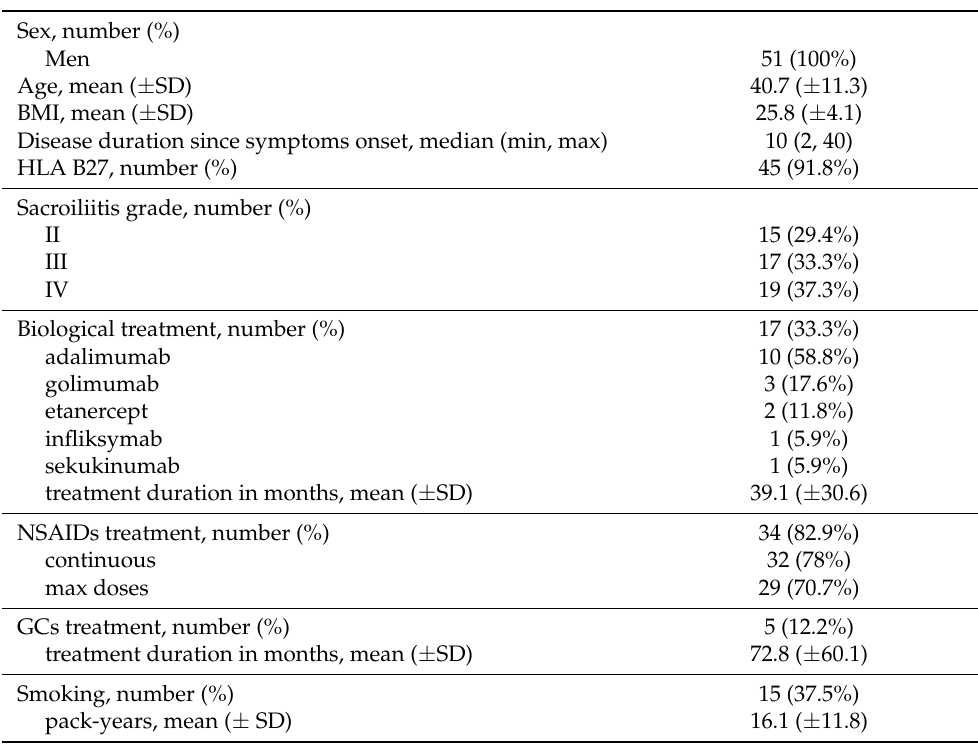
Table 1. Patients’ characteristics. GCs—glucocorticoids, NSAIDs—non-steroid anti-inflammatory